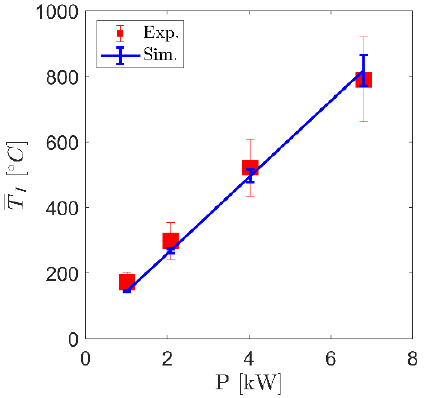
Figure 9. Average inventory temperatures (T I ) at the end of charging period after 30 min. Table 3. Time of activating the active cooling (t c